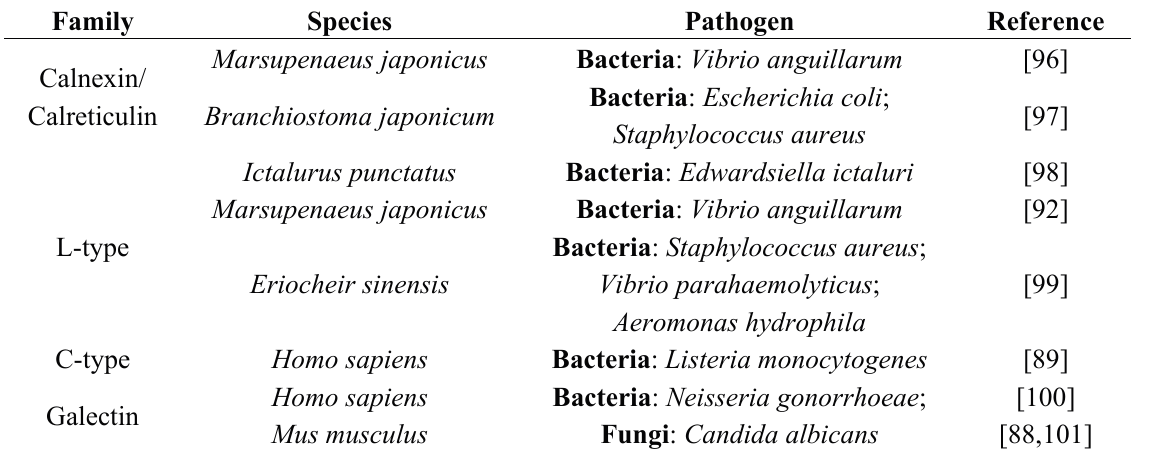
Table 2. Animal lectins showing antimicrobial